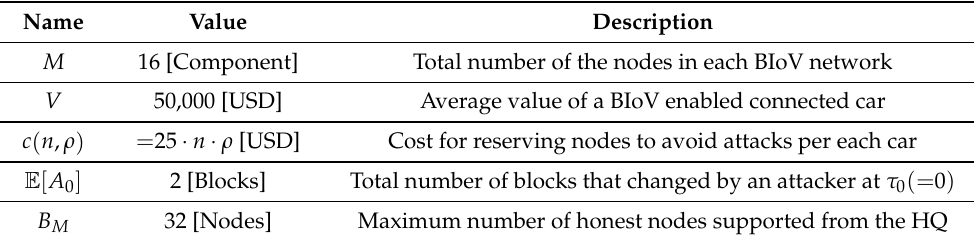
Table 2. Initial conditions for the cost